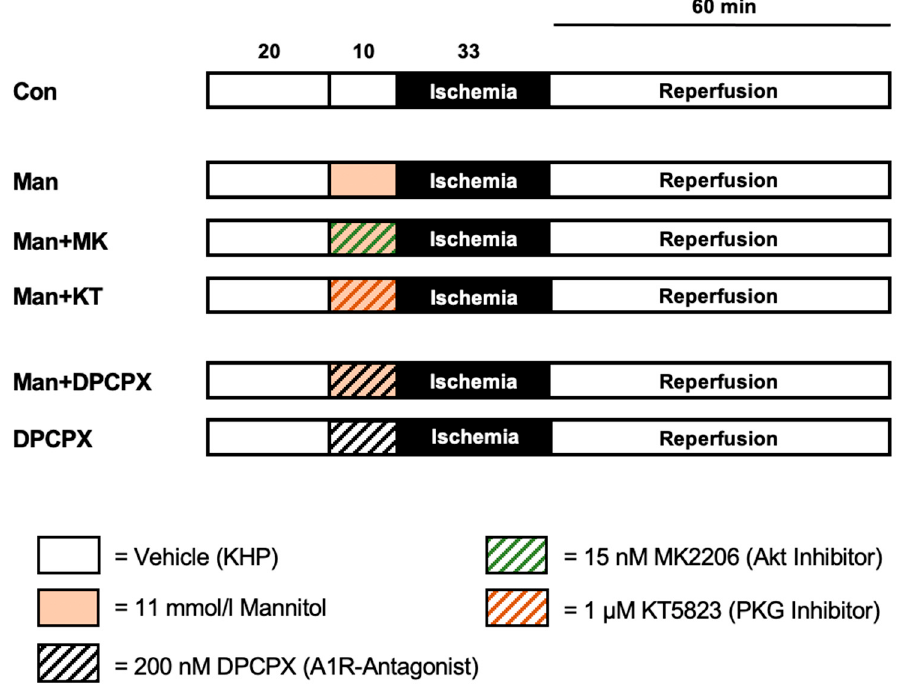
Figure 2. Experimental protocol. Con = control; Man = Mannitol; MK = MK2206 (Akt